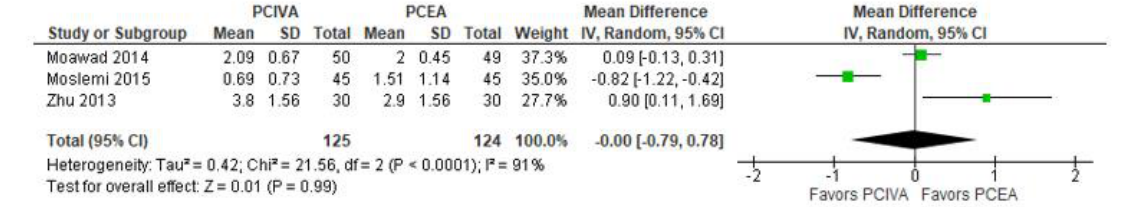
Figure 2. Postoperative pain scores at rest (at 24 h) [17 – 19].